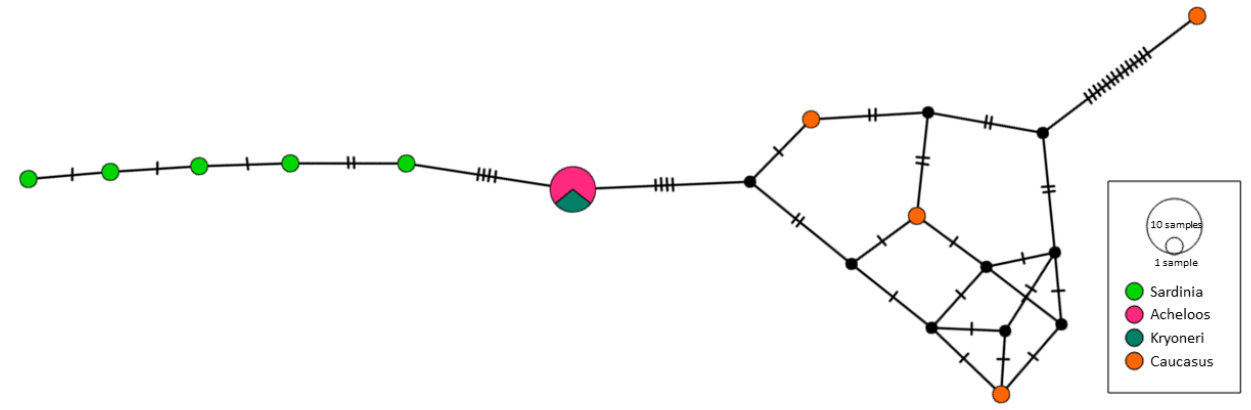
Figure 3. Median-joining haplotype network based on 702 bp of 28S rDNA from the newly sequenced individuals of Xenoligophoroides cobitis from Greece, and the sequences from Dmitrieva et al. [17]. Genotypes are represented by circles with the size of the circle correlating with the number of specimens displaying the respective genotype. Colors denote sampling localities; genotypes are connected with lines, indicating the number of mutations between them. Colors correspond to the sampling localities in Figure 4.